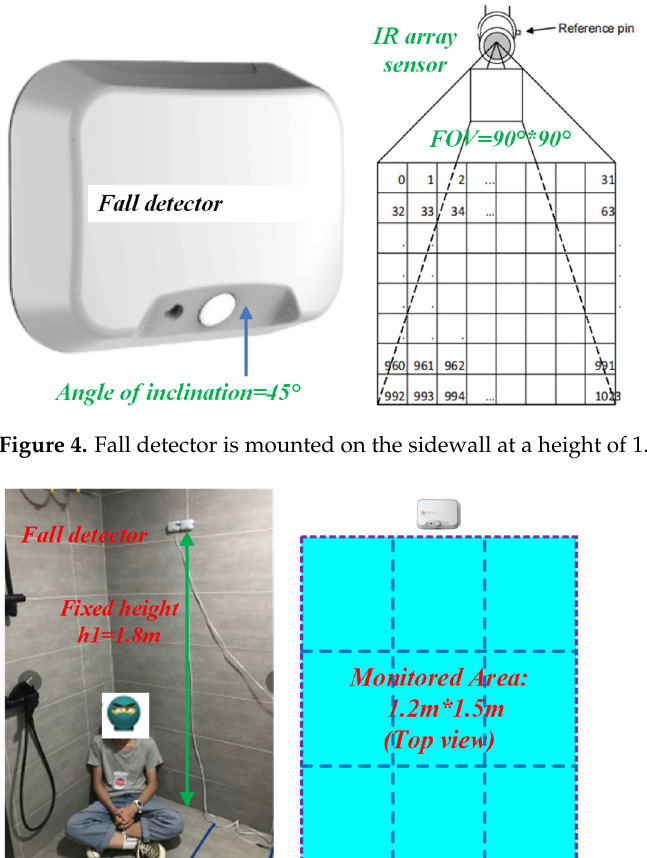
(3) Figure 7. Bode diagram of the first − order low − pass filter.